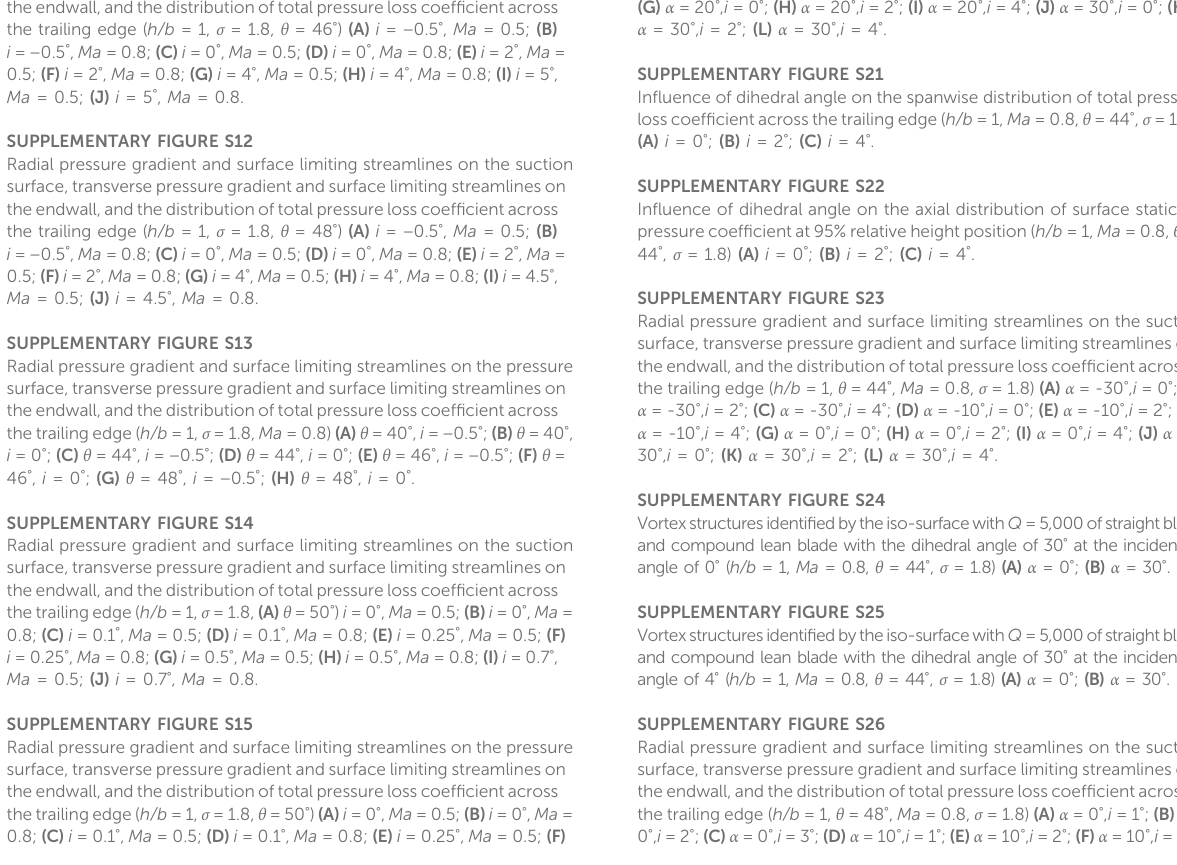
SUPPLEMENTARY FIGURE S15 Radial pressure gradient and surface limiting streamlines on the pressure surface,transversepressuregradient and surfacelimiting streamlineson theendwall,andthedistributionoftotalpressurelosscoef fi cientacross thetrailingedge( h/b =1, σ =1.8, θ =50 ° ) (A) i =0 ° , Ma =0.5; (B) i =0 ° , Ma = 0.8; (C) i = 0.1 ° , Ma = 0.5; (D) i = 0.1 ° , Ma = 0.8; (E) i = 0.25 ° , Ma = 0.5; (F)